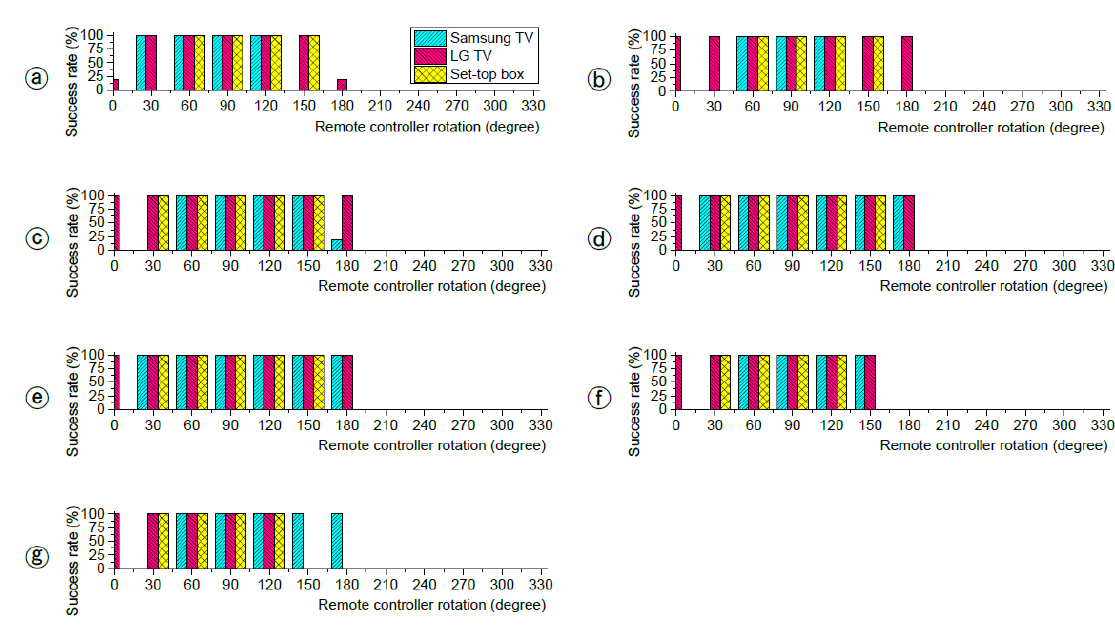
Figure 6. IR reception success rate according to